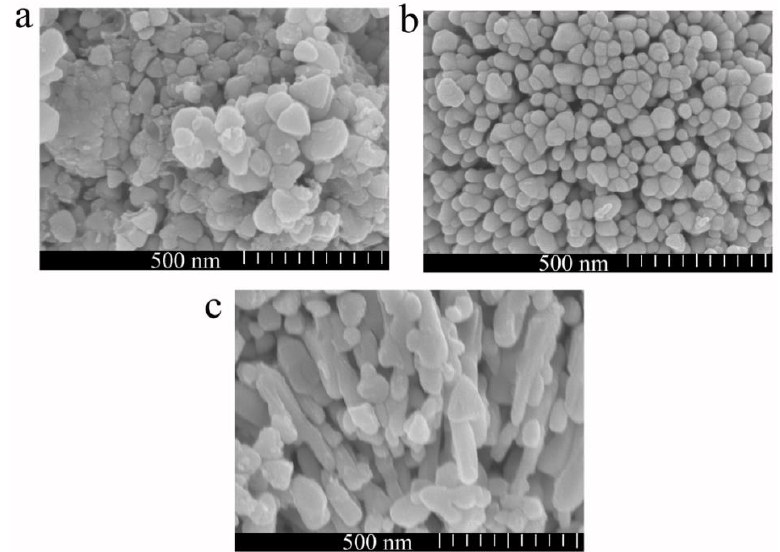
Figure 4. SEM surface image of ( a ) ZnO and ( b ) ZnO/AuNPs nanorods (sample 3), ( c ) corresponding cross-section image of ZnO/AuNPs nanorods (sample 3).